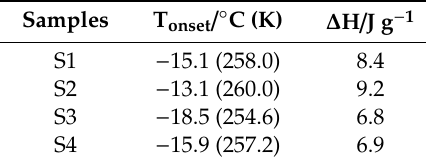
Table 1. Temperature and enthalpy